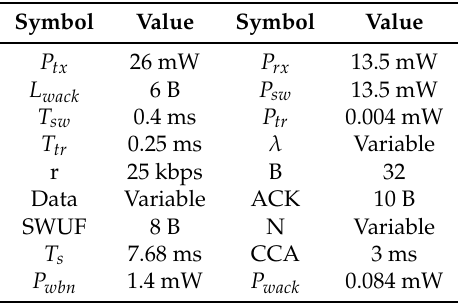
Figure 16. A simulation scenario generated in NS2. Table 4. Input parameters. SWUF, short wake up frame.